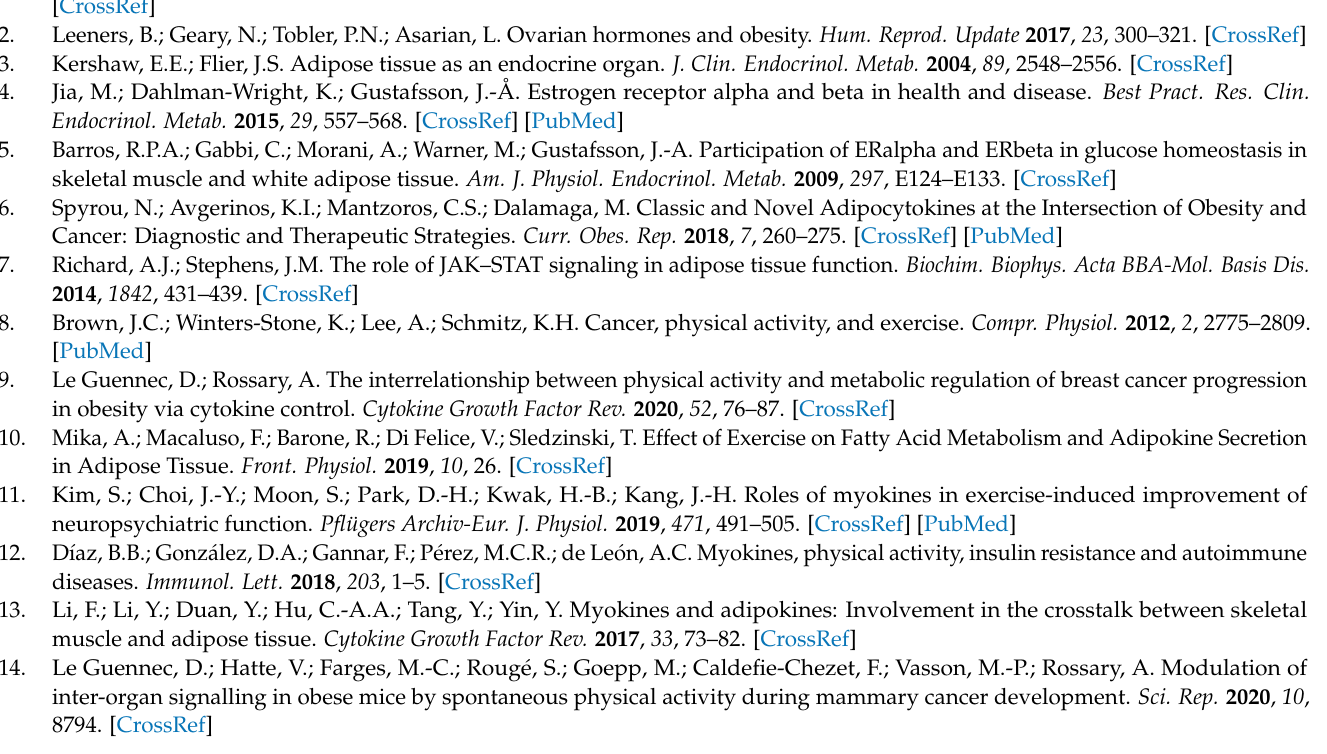
flow cytometry staining, Table S3: PCR primers, Table S4: Cytokines and matrix metalloproteases, Figure S1: Gating